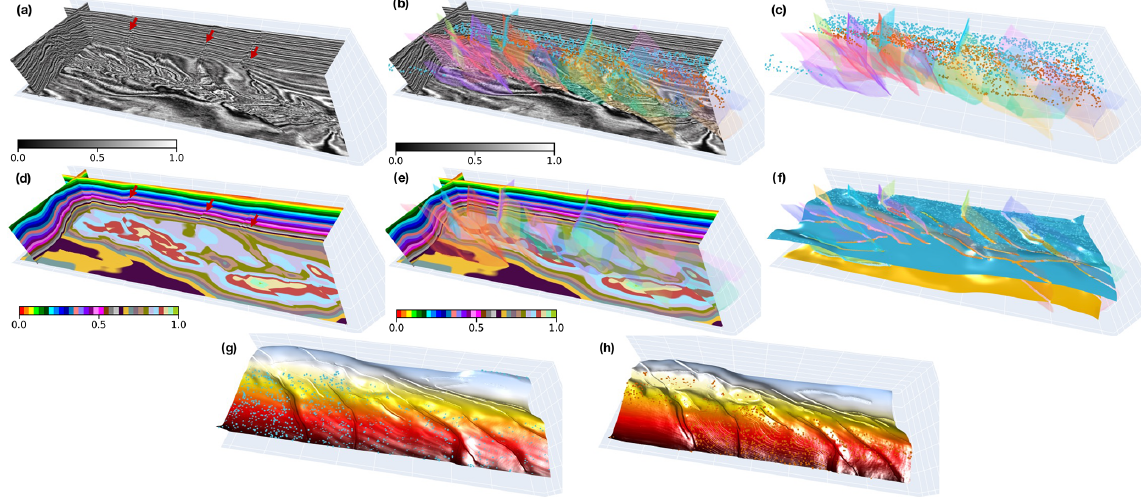
Figure 12. The second real-world data application. We display seismic volumes (a) overlaid with structural data (b) that are interpreted from the seismic volumes, input horizon and fault points (c) , the modeling result (d) overlaid with faults (e) , modeled interfaces extracted from the prediction (f) , and each of the recovered full horizon surfaces in panels (g) and (h) , respectively. Note that we rotate the modeled interfaces in panels (g) and (h) by 180 ◦ and use color with vertical coordinates for a better visual